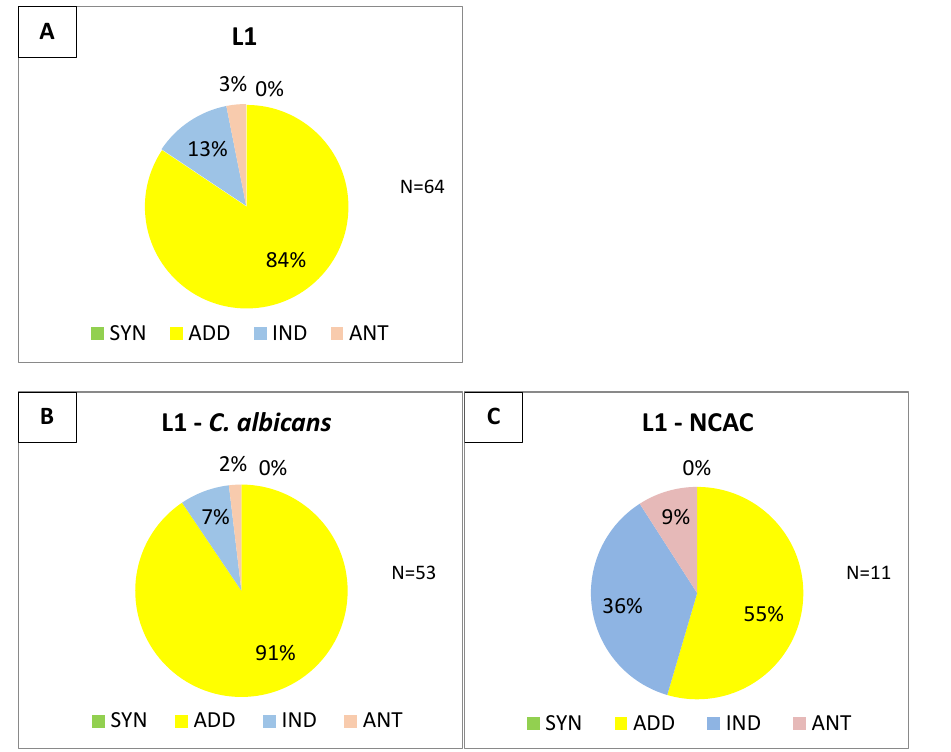
Figure 4. Distribution of FIC indices for combination of fluconazole–L1: ( A ) total—64 strains; ( B ) C. albicans —53 strains; ( C ) NCAC—11 strains.